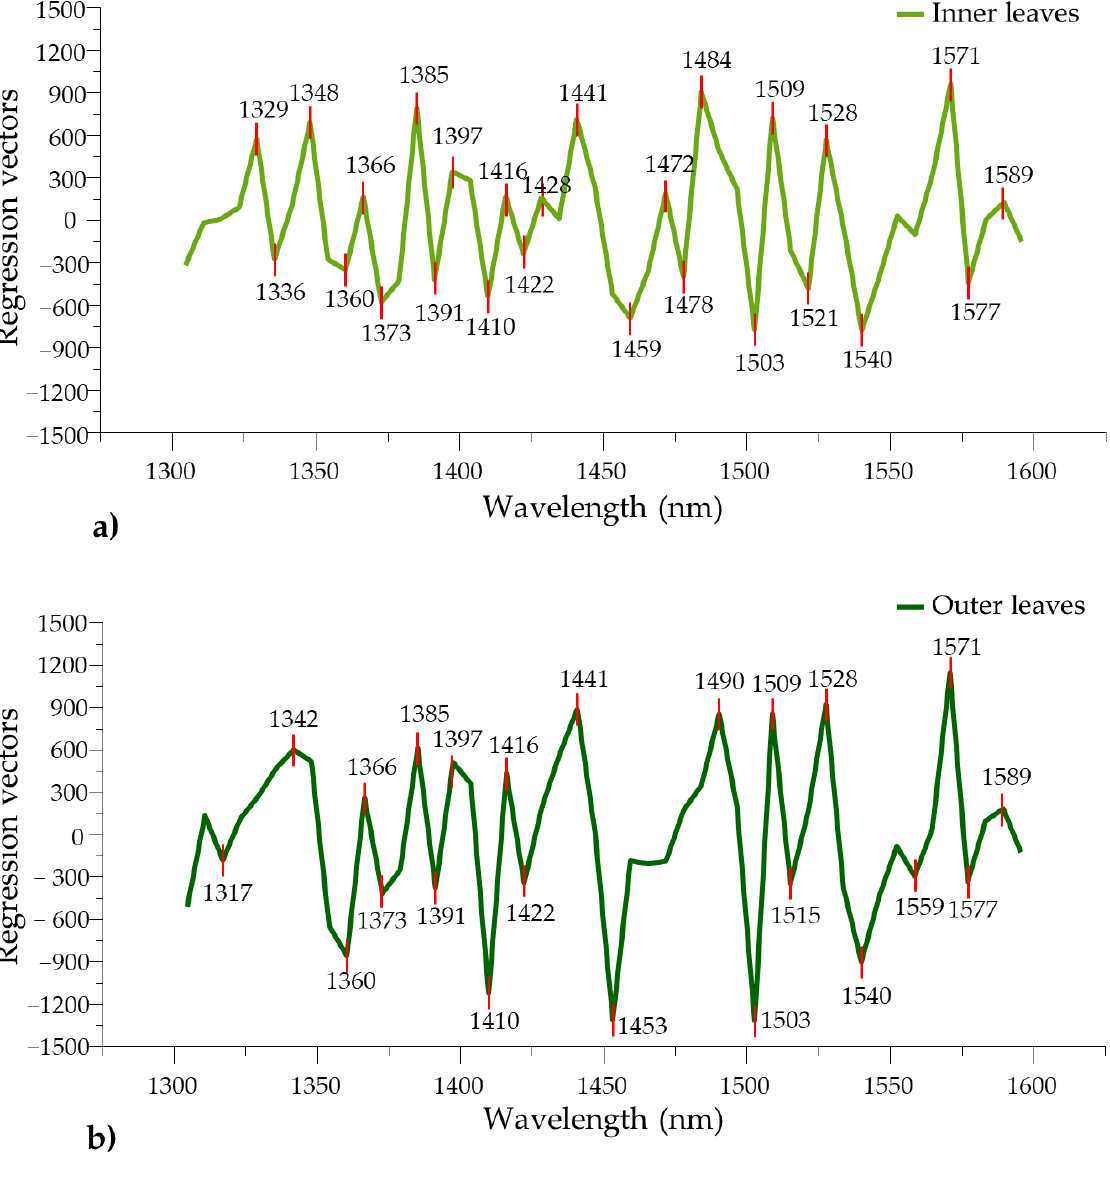
Figure 12. PLS regression vectors for storage time prediction. ( a ) Data of inner leaves (deTr-treated spectra, N = 367, NrLV = 9) and ( b ) data of outer leaves (deTr-treated spectra, N = 364, NrLV = 9).